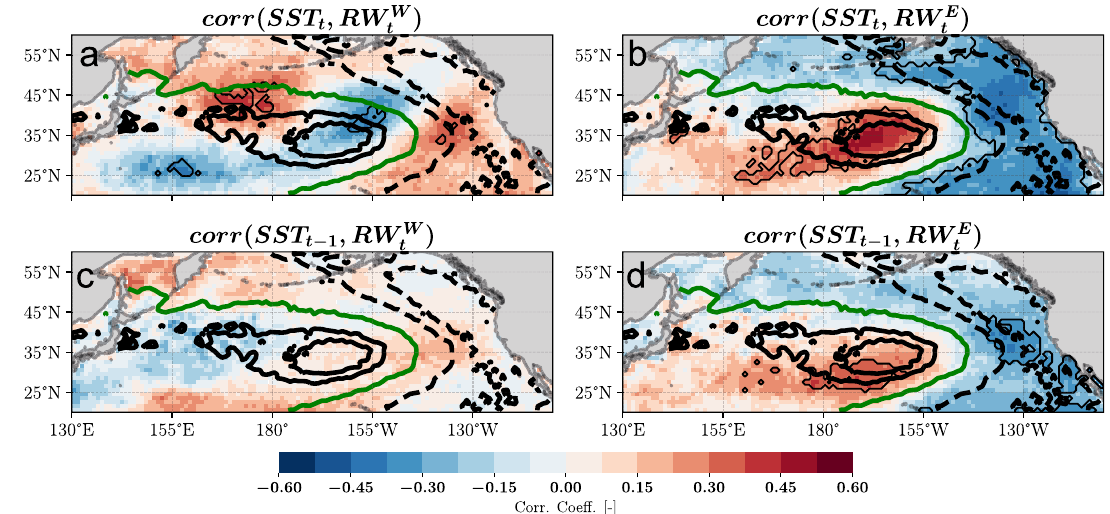
Fig. 3 Instantaneous and lag 1 correlation maps of SSTA versus the May – August Rossby wave timeseries. Panel ( a ) and ( c ) show the western RW, panel ( b ) and ( d ) show the eastern RW. The Rossby wave patterns are still the as depicted in Fig. 1, yet the data is now aggregated to 2-month means. For the signi fi cance ( α FDR = 0.05), we correct for the False Discovery Rate using the Benjamini/Hochberg correction. Gridcells are highlighted by the thin black contour lines if they are signi fi cant at least 5 out of 10 training subsets. The thick contour lines indicate the negative PDO pattern (1st EOF loading pattern) ranging from − 0.7 (black dashed) to 0 (green solid) to 0.7 (black